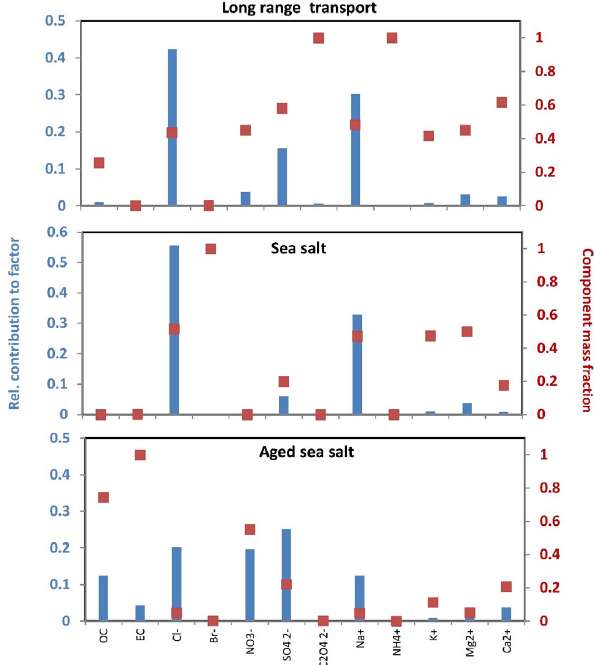
Figure 11. Source profiles identified from measured PM 10 com- ponents at CVAO. Results are from 671 analyzed filters. The rela- tive contribution of each species to a given factor is represented by blue bars, while the relative contribution of each factor to the total species concentration is represented by a red square (right